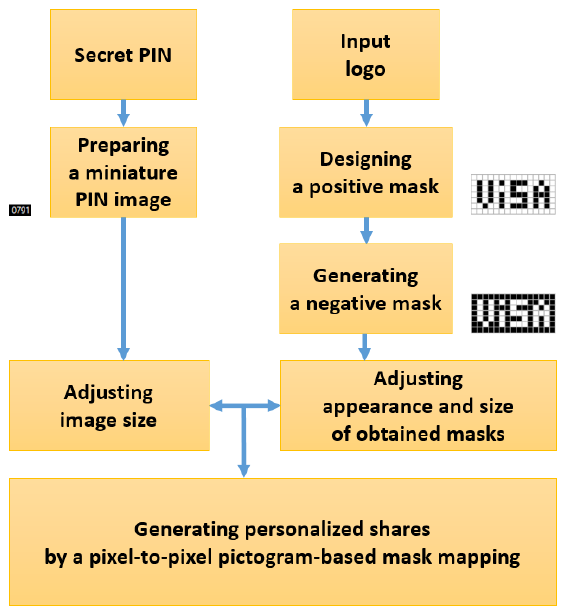
Figure 6. Workflow diagram of the graphic designer for the pictogram-based personalization of share